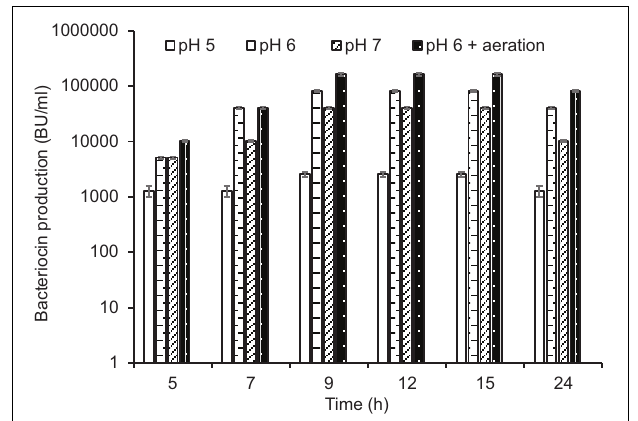
FIGURE 4 | GarKS production of the recombinant producer (KS1546-pA2T) in cultivation at constant pH (pH at 5, 6, or 7) or at constant pH 6 and aeration (50 − 60% dissolved oxygen). Each culture was started by adding 2% (v/v) culture inoculum in 1.5 l of PM-T medium containing erythromycin at final concentration of 5 µ g/ml. Standard deviations were based on triplicate